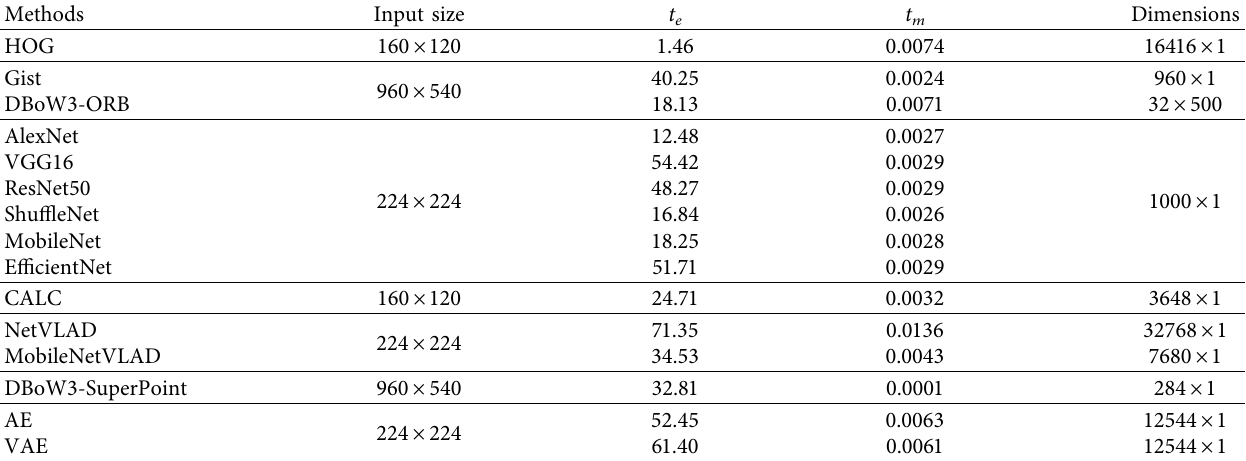
Table 6: Times (in milliseconds) for feature encoding t e (ms) as well as descriptor matching t m (ms), using a CPU-based platform.